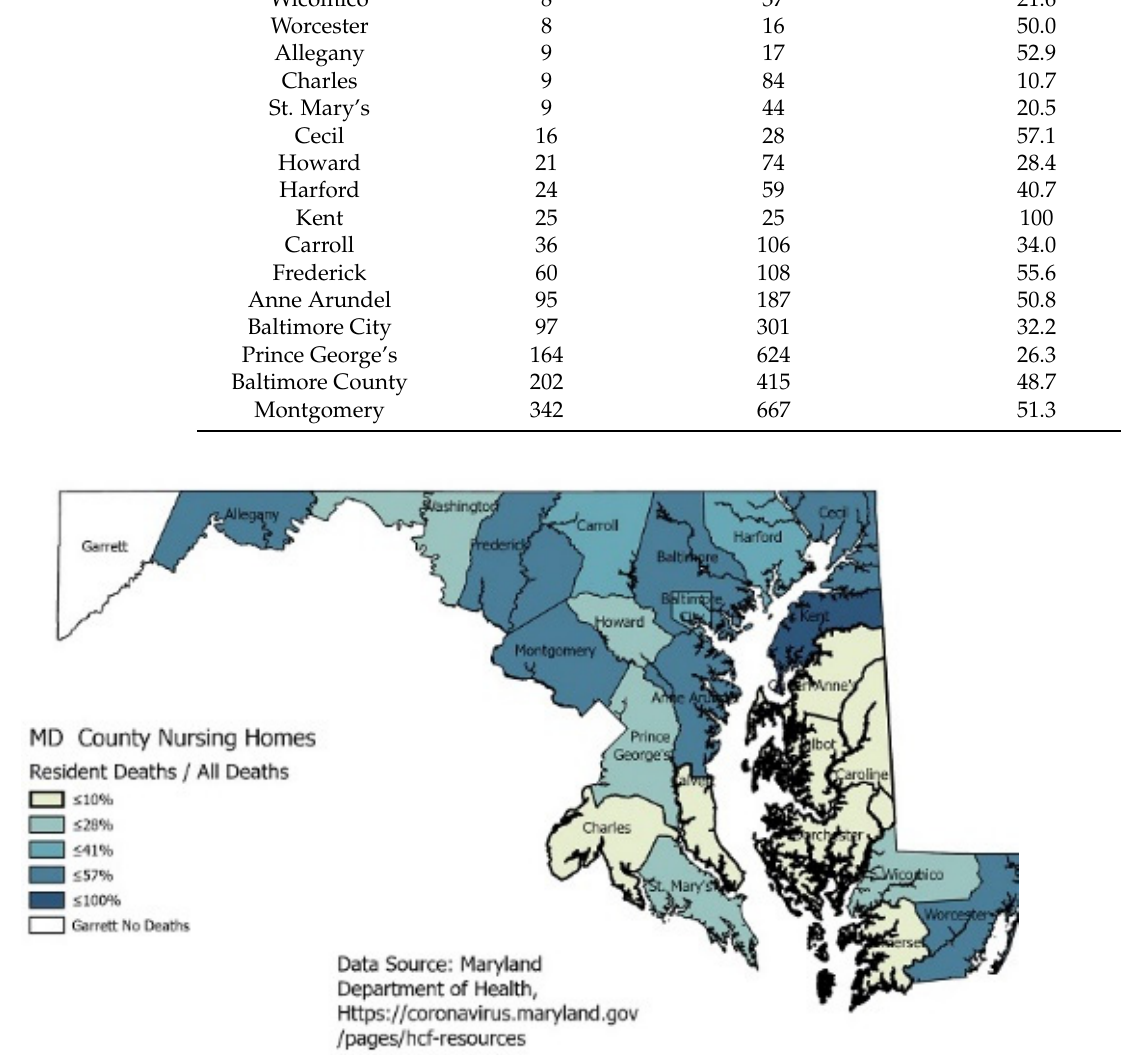
Figure 5. Map showing COVID-19 deaths in Maryland by county.